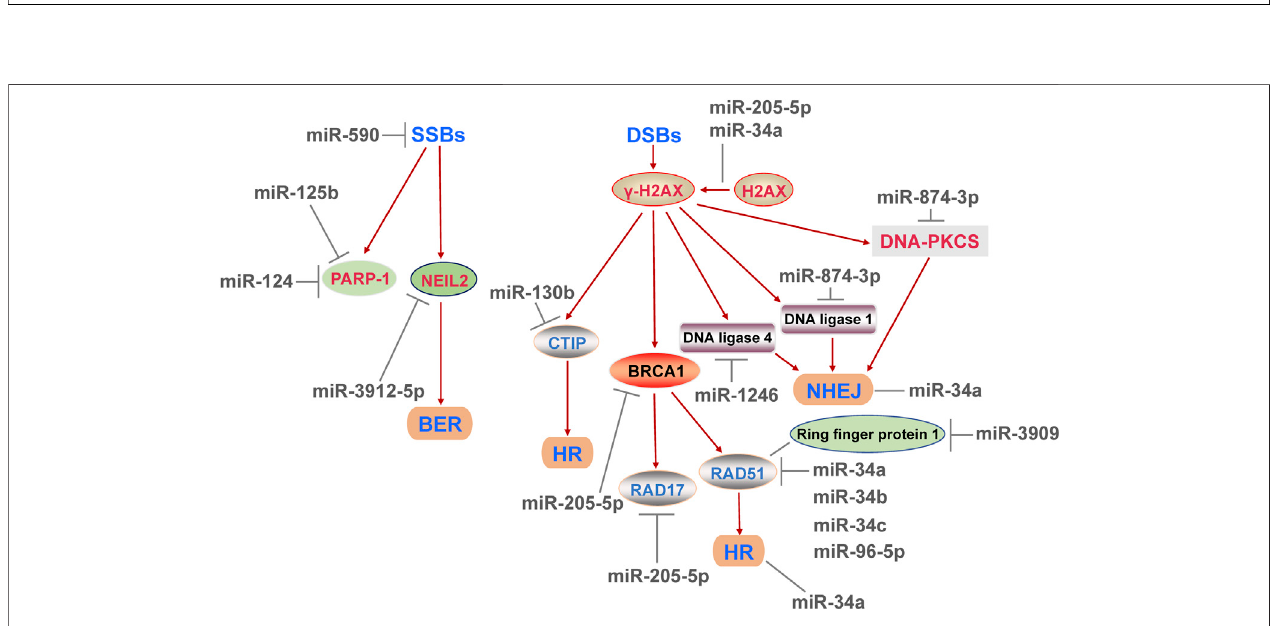
FIGURE 3 | MicroRNAs affect various DNA repair pathways at least includes base excision repair, homologous recombination repair and non-homologous end joining repair, and regulate the repair ef fi ciency of DNA single-strand and double-strand breaks, and ultimately have an impact on DNA damage response.